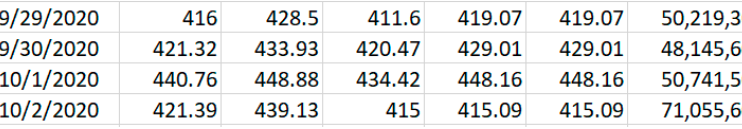
Figure 2. Stock Market Dataset.